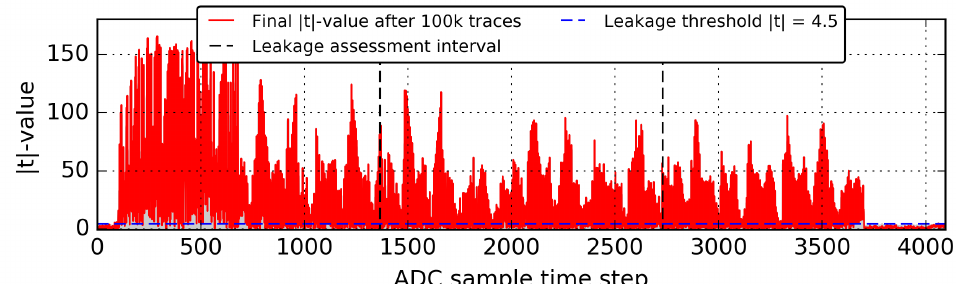
Figure 8: First order leakage assessment results based on a fixed-vs-random t-test for 100k traces collected during modular exponentiation on the STM32F407VG Discovery #1.